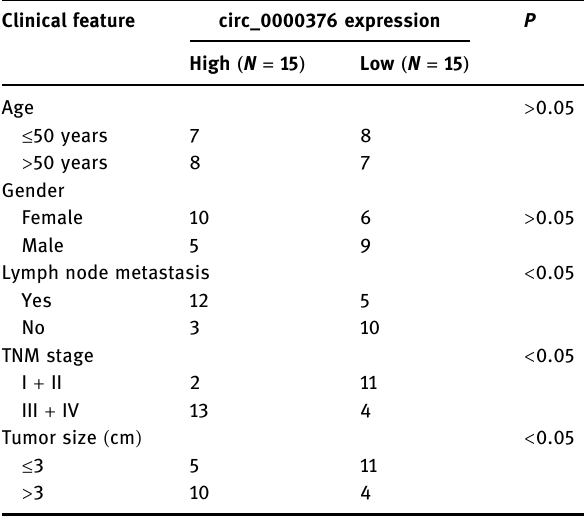
Table 1: Association between circ_0000376 expression and clinical features of NSCLC patients Clinical feature